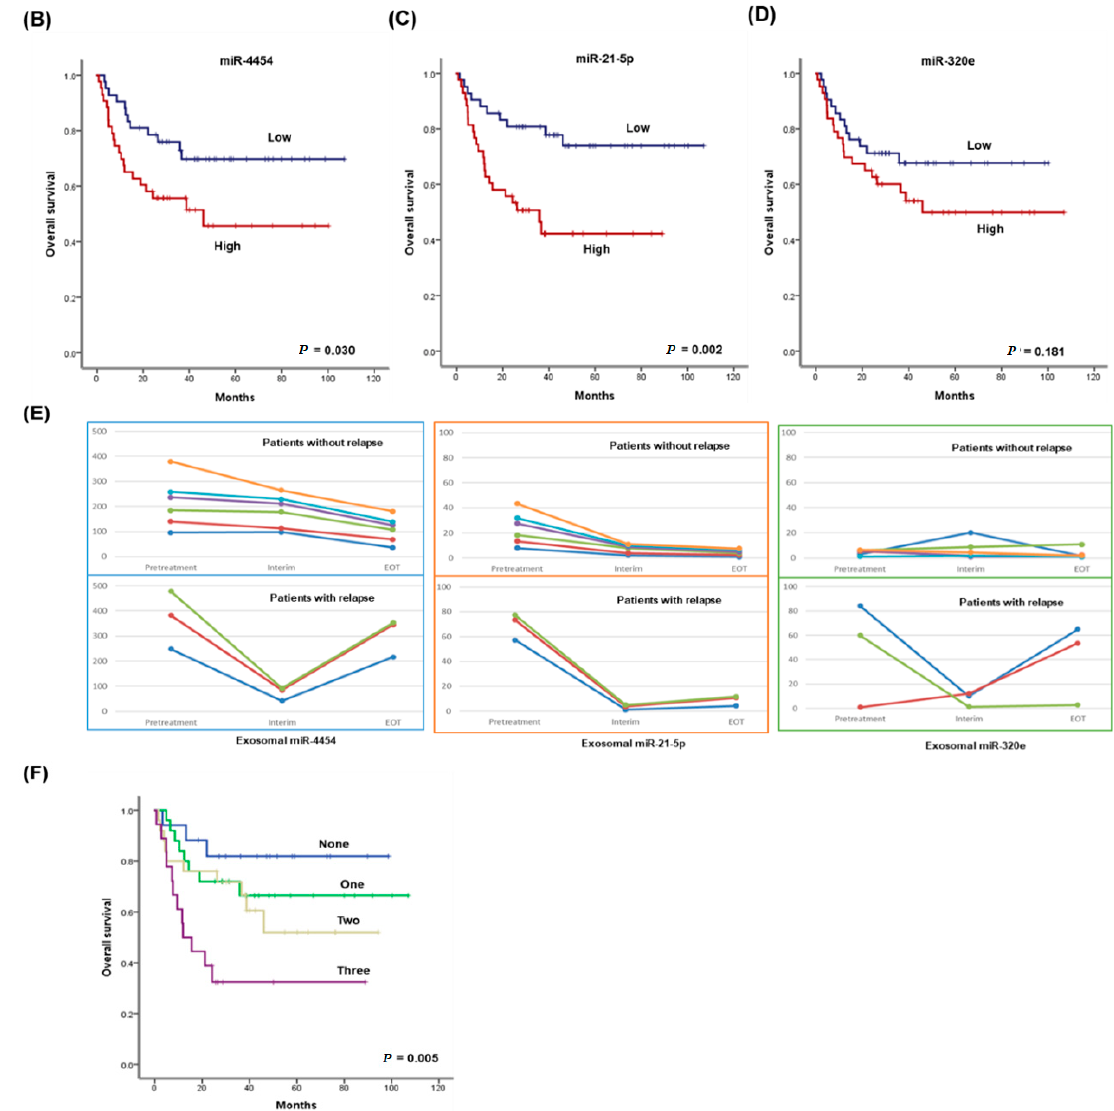
Figure 3. Exosomal miRNA markers correlated with clinical responses. ( A ) Venn diagrams show commonly upregulated miRNAs in both patient-serum-derived and NKTL cell-line-derived exosomes. ( B ) Overall survival of patients with extranodal NK/T-cell lymphoma (ENKTL) according to serum levels of exosomal miR-4454. ( C ) The pretreatment high miR-21-5p group showed poor overall survival compared with the low miR-21-5p group. ( D ) The pretreatment high exosomal miR- 320e group showed a tendency of poor survival compared with the low exosomal miR-320e group.